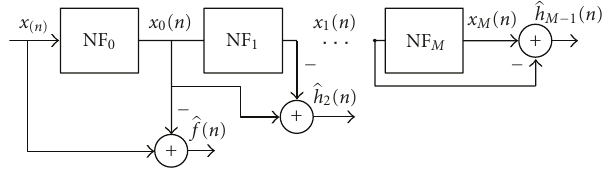
Figure 6: Scheme of the signal processing